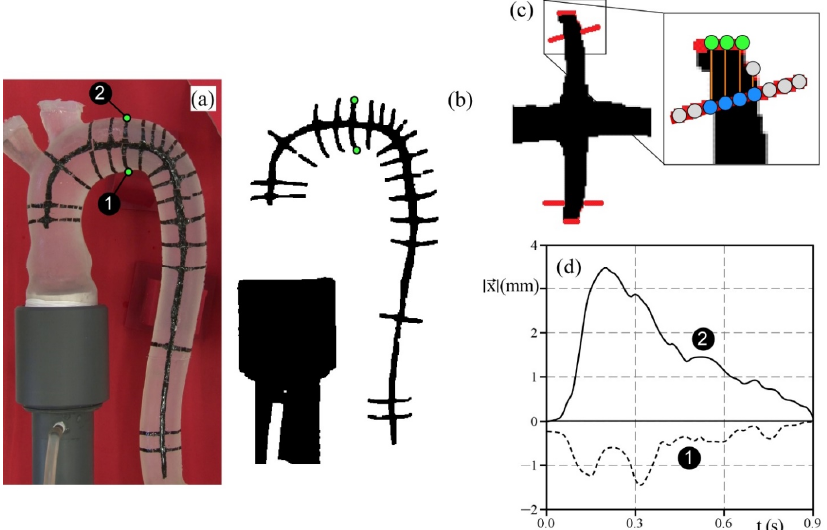
Figure A1. Determination of the edge displacement. ( a ) Acquisition of the phantom image from the camera. ( b ) Segmented image by the morphology function of LabView. ( c ) Detection of the edge marker starting from the manually crossed segment (red lines). Blue circles denote the pixels used by the algorithm to track the edge contour (green circles); gray pixels are pixel selected that do not contribute to the contour definition. ( d ) Example of an estimate of displacements for cardiac cycle for the points 1 and 2 of panel a and b.